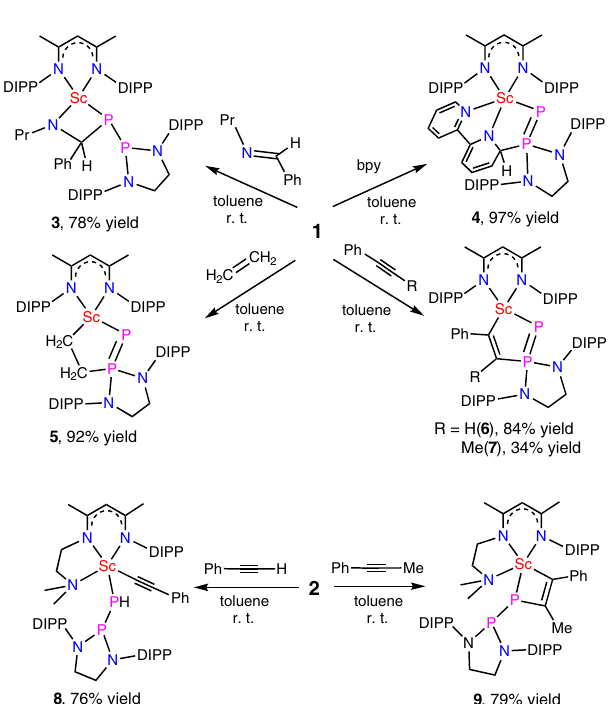
Fig. 3 Reactivity of scandium phosphinophosphinidene complexes. Reactions of complex 1 with N-benzylidenepropylamine, 2,2 ′ -bipyridine, ethylene, phenylacetylene and 1-phenyl-1-propyne, and reactions of complex 2 with phenylacetylene and